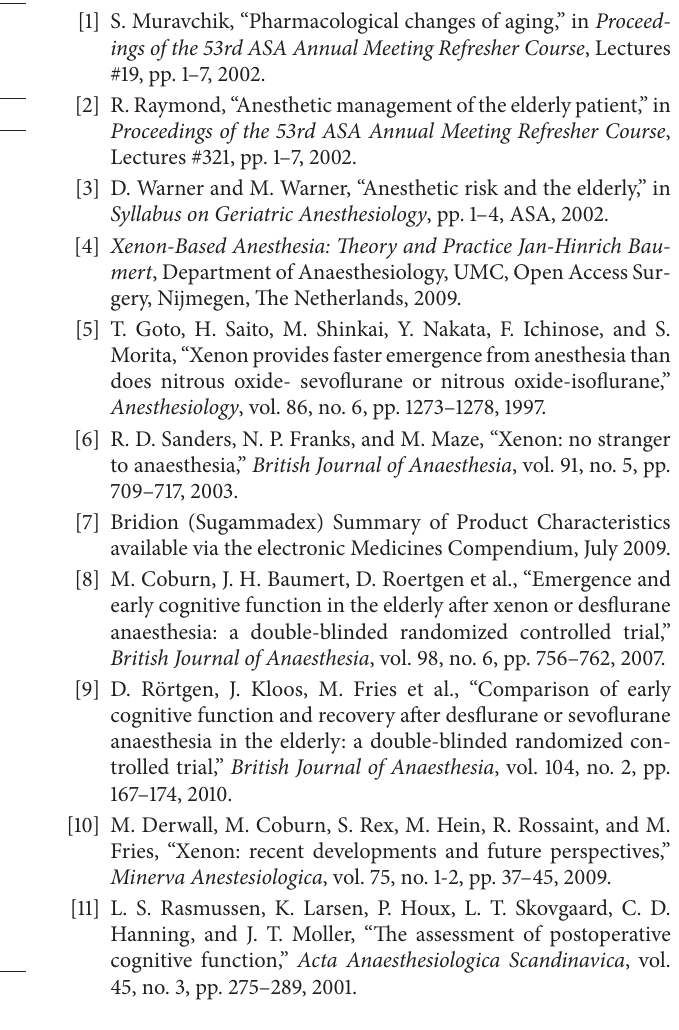
Table 3: BIS: bispectral